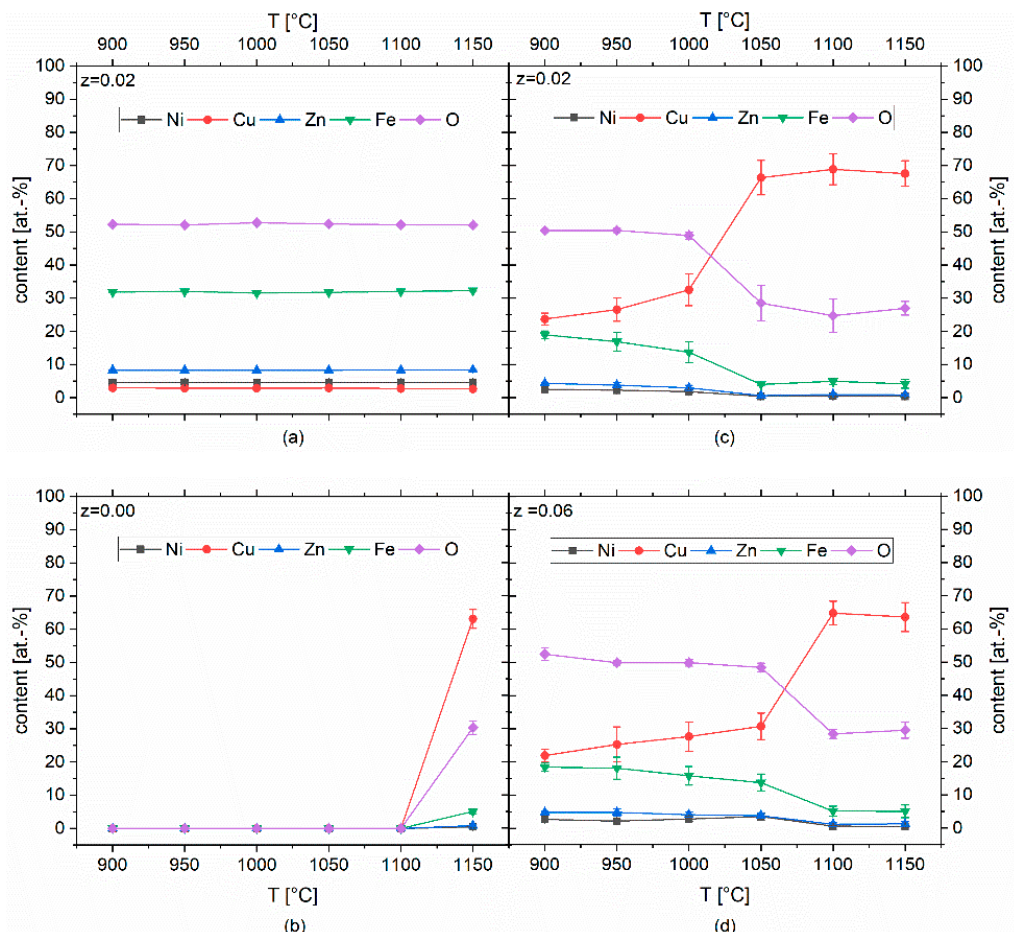
Figure 4. Chemical composition determined using EDX point scans vs. sintering temperature of ( a ) ferrite matrix grains (z = 0.02) and triple points or grain boundary regions for ( b ) z = 0.00, ( c ) z = 0.02, and ( d ) z = 0.06 . The distribution of the copper oxide phase in the microstructure was studied in some detail. In addition to SEM micrographs, Figure 2 shows EDX mappings of the Cu distri- bution for all samples and sintering temperatures T s . In the case of stochiometric ferrites (z = 0), a homogeneous distribution of Cu is found, except for the sample sintered at 1150 °C, where enrichment of Cu is detected at grain boundaries between very large grains.